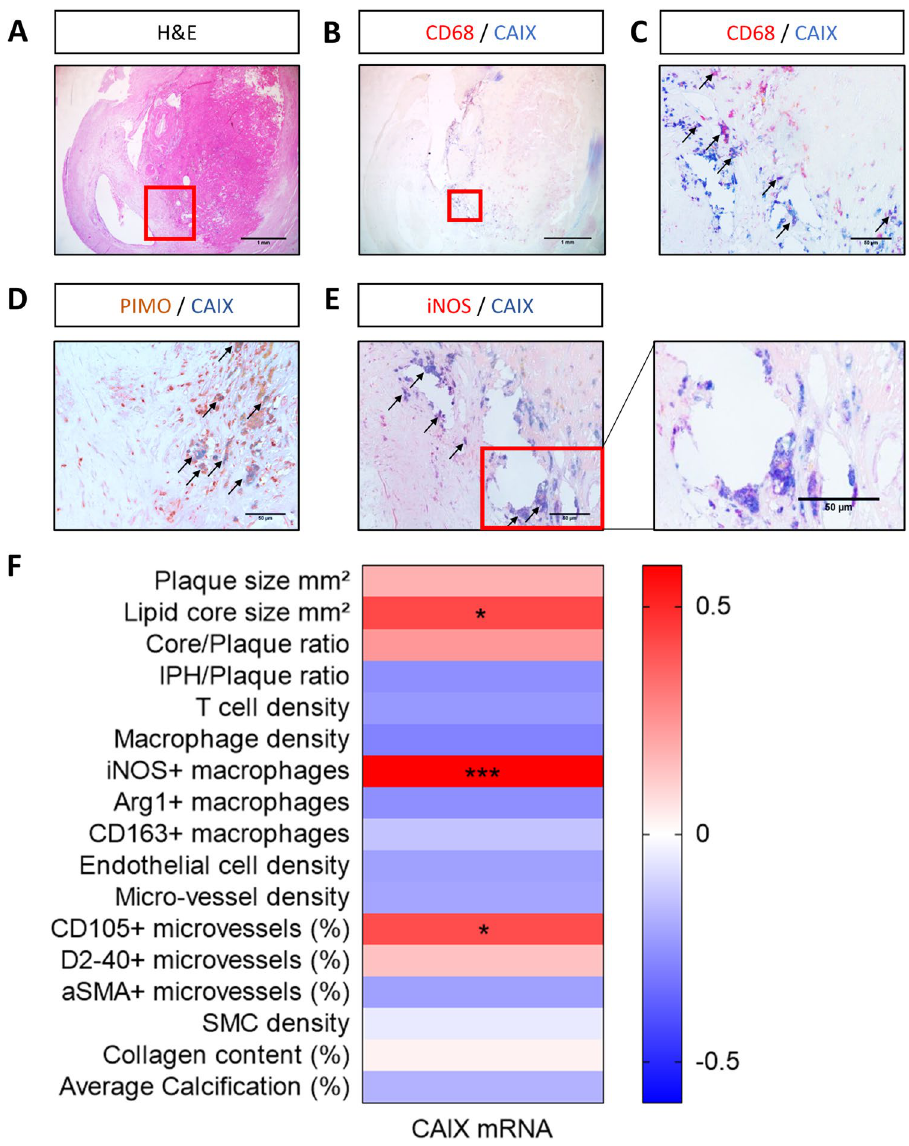
Figure 1. CAIX was present in human atherosclerotic plaque and co-localized with CD68 + cells. ( A ) Microphotograph of hematoxylin and eosin (H&E) stained human unstable carotid artery plaque. Red square represents region that was magnified in all stainings. ( B ) Double staining of CAIX (blue) and CD68 (red) in unstable human atherosclerotic plaque, magnification of red square is depicted in ( C ). Arrows indicate double positive cells. ( D ) Unstable human atherosclerotic plaque of patient injected with pimonidazole to detect hypoxia (brown) or ( E ) iNOS (red), and CAIX (blue), arrows indicate double-positive areas accompanied by an additional zoomed in area, ( F ) Heatmap of Pearson correlations of CAIX mRNA in unstable human plaque segments with plaque traits, determined on adjacent histology slides. All plaque sections originate from the MaasHPS cohort. Arg1; arginase 1. αSMA; alpha smooth muscle cell actin. D2-40; podoplanin. iNOS; inducible nitric oxide synthase. IPH; intra-plaque hemorrhage. MVD, microvessel density NA; not applicable. * p < 0.05, ** p < 0.01, *** p <